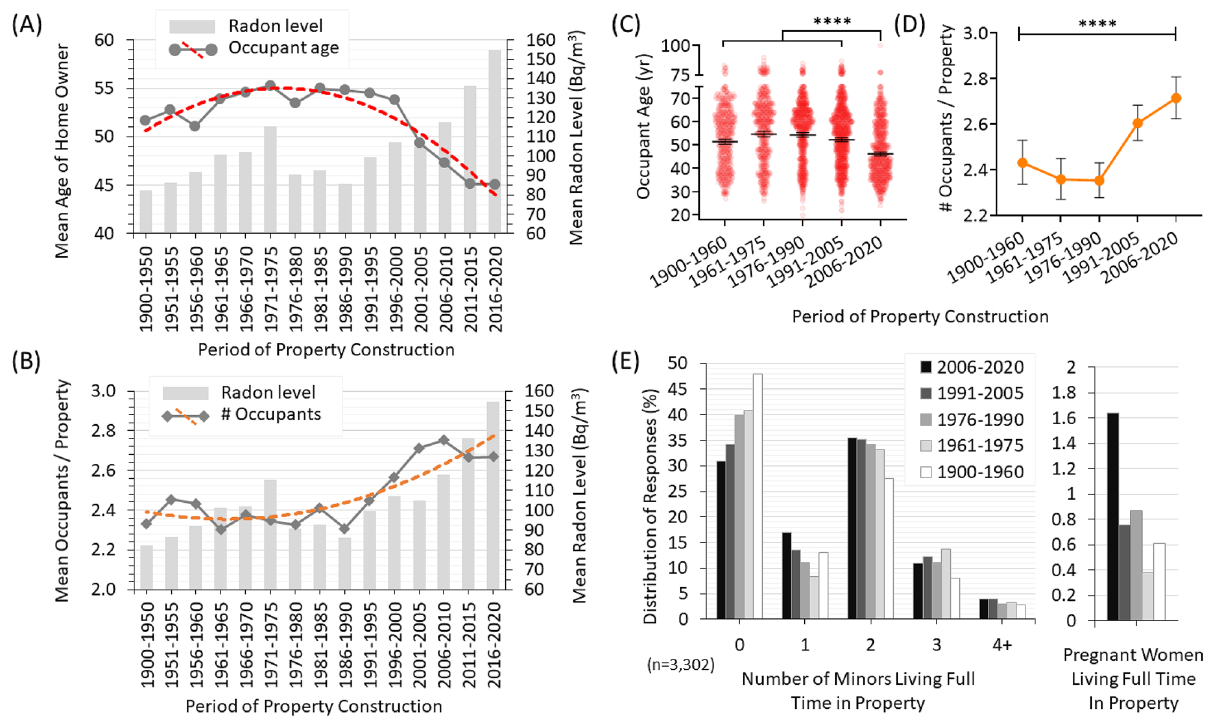
Figure 3. Canadian radon exposure as a function of residence age, occupant age, number of occupants and presence of minors and pregnant occupants. ( A ) Long term radon-test outcomes (grey bars, right y-axis) and geometric mean age of primary homeowner/renter (grey circles, line overlaid with red dashed polynomial trendline, left y-axis) for Canadian residences grouped into 5 year bracket (x-axis). ( B ) Long term radon- test outcomes (grey bars, right y-axis) and geometric mean age of the number of full time occupants (grey diamonds, line overlaid with orange dashed polynomial trendline, left y-axis) for Canadian residences grouped into 5 year bracket (x-axis). ( C ) Scatter plot of occupant age data from ( A ) by property construction period, showing 2-way ANOVA analysis of properties from 2020–2006 pairwise compared to all other period brackets. **** p < 0.0001. ( D ) Line graph of the geometric mean occupants per property (from B ), showing 2-way ANOVA analysis of all comparisons. **** p < 0.0001. ( E ) The percent distribution of responses for reported number